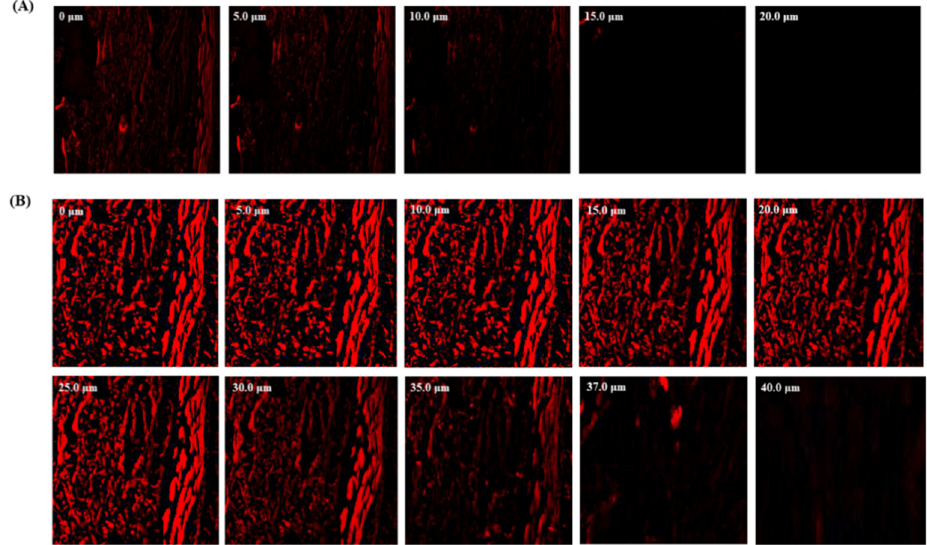
Figure 6. CLSM images in optical cross section perpendicular to goat nasal mucosa membrane ( A ) treated with PIP suspension and ( B ) treated with PIP-SPLopt formulation.